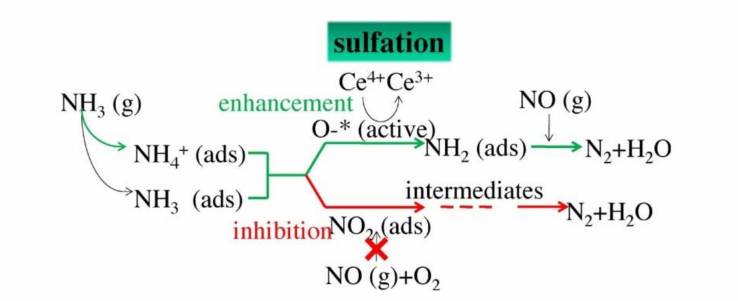
Figure 12. Reaction mechanism of Ce–Fe / WMH catalyst